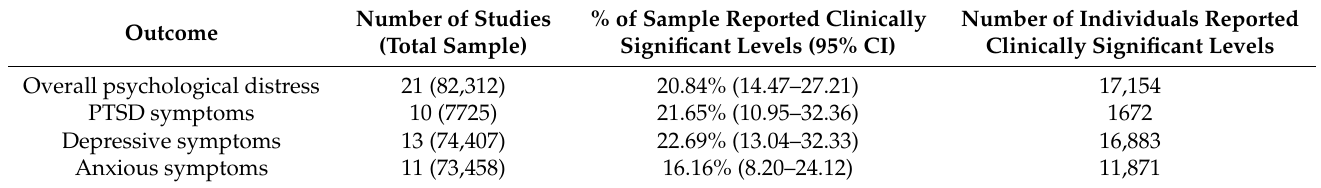
Table 2. Summary of aggregated